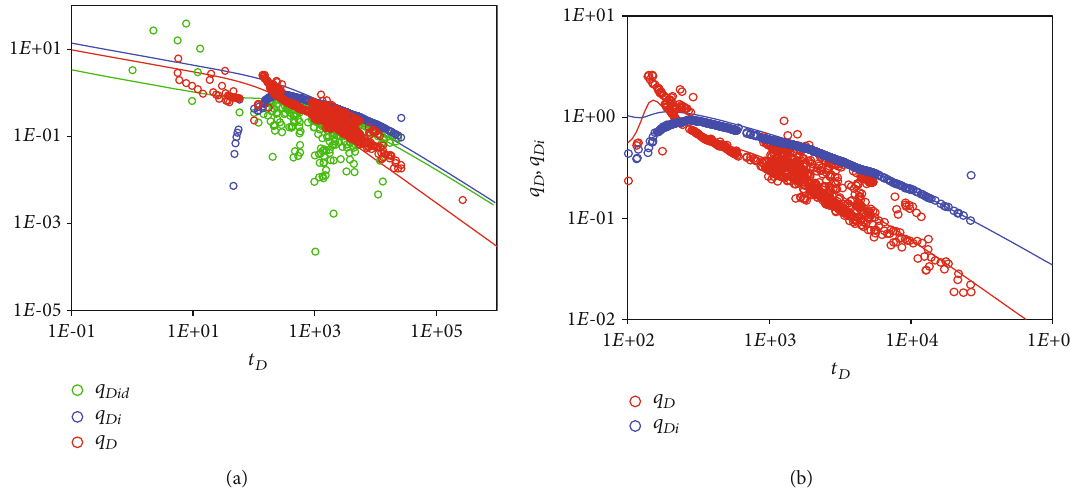
Figure 13: Production data for gas well YY-2 ~ YY-5.